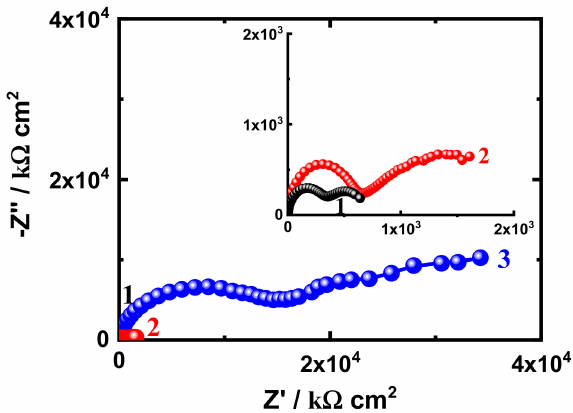
Figure 9. Nyquist plots obtained for SN1, SN3, and SN5 after their immersion for 20 days in 3.5% NaCl solutions.